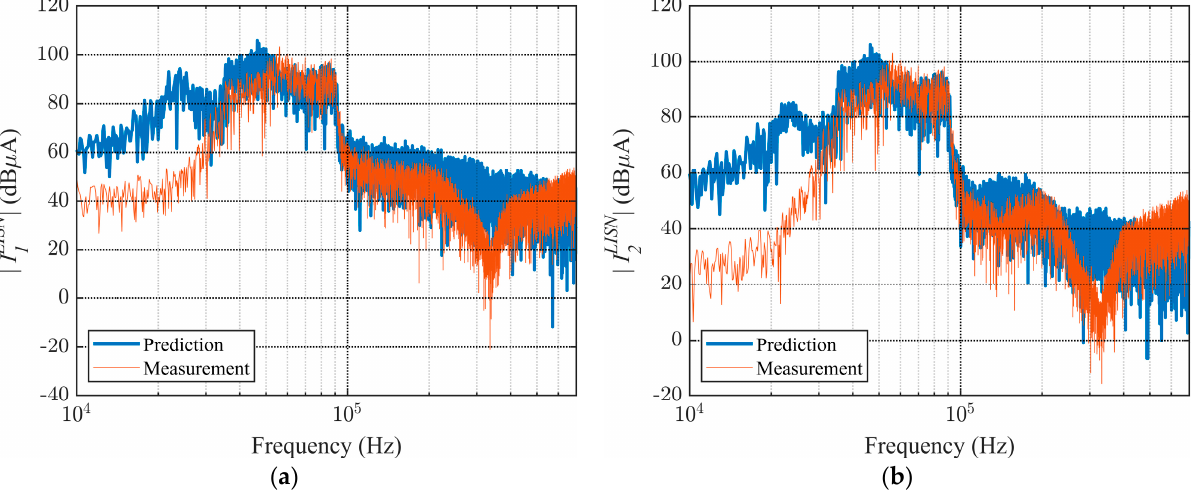
Figure 14. Currents ( a ) I LISN and ( b ) I LISN obtained from the prediction model and the measurement of test case #2 (with LISN B2). The PLC Tx modem is represented according to Section 3.